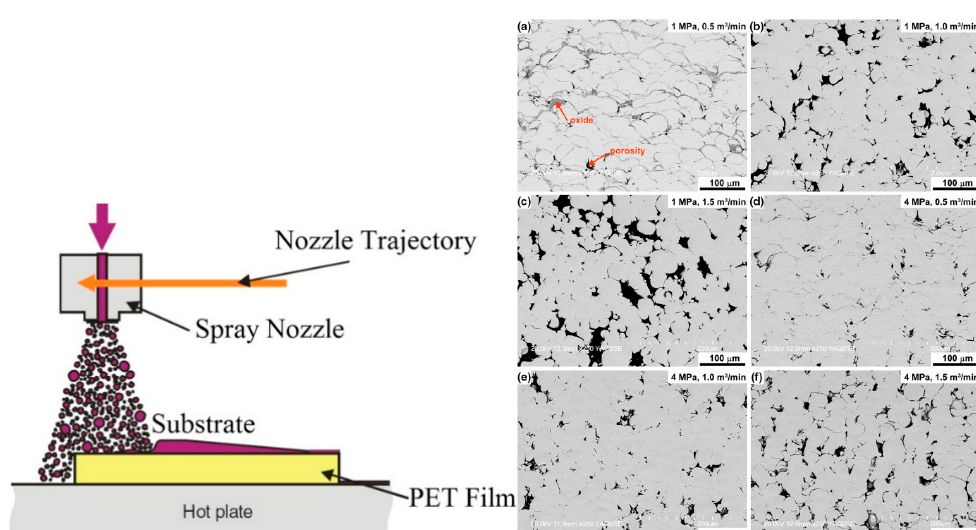
Figure 12. Left: A schematic of warm spray coating technique and its setup [115]. Right: Cross-section BSE micrographs of warm spray-deposited Ti-6Al-4V on low-carbon steel substrate processes spray pressure and nitrogen flow rates of ( a ) 1 MPa and 0.5 m3/min, ( b ) 1 MPa and 1 m3/min, ( c ) 1 MPa and 1.5 m3/min, ( d ) 4 MPa and 0.5 m3/min, ( e ) 4 MPa and 1 m3/min, and ( f ) 4 MPa and 1.5 m3/min, respectively [116].